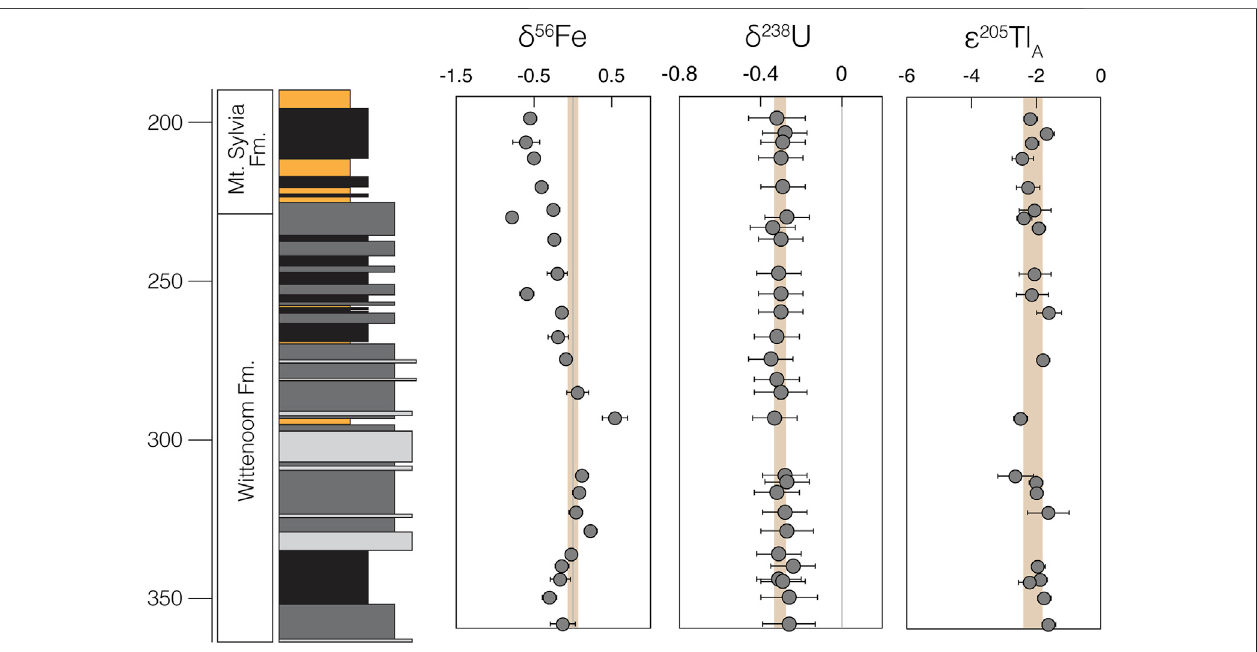
FIGURE3| Heavymetalisotopedatageneratedduringthecurrentstudy. δ 56 Feand δ 238 Uvaluesareforbulk-shale,while ε 205 Tl A valuesareforleached(authigenic) fractions.Thebrownshadedregionineachpanelrepresentstheestimatedaveragebulkuppercontinentalcrustvalueforthatisotopesystem,whichisinallcasessimilar to the estimated mantle value. Errors are either equal to the highest 2SD reproducibility of our standards or the individual sample ’ s reproducibility, whichever is greater.